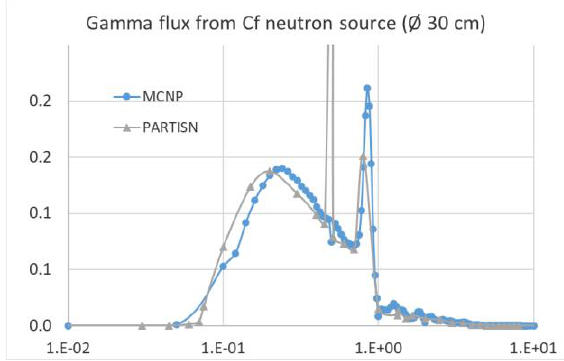
Fig. 4. Comparison between the gamma spectra calculated using the MCNP and PARTISN codes.